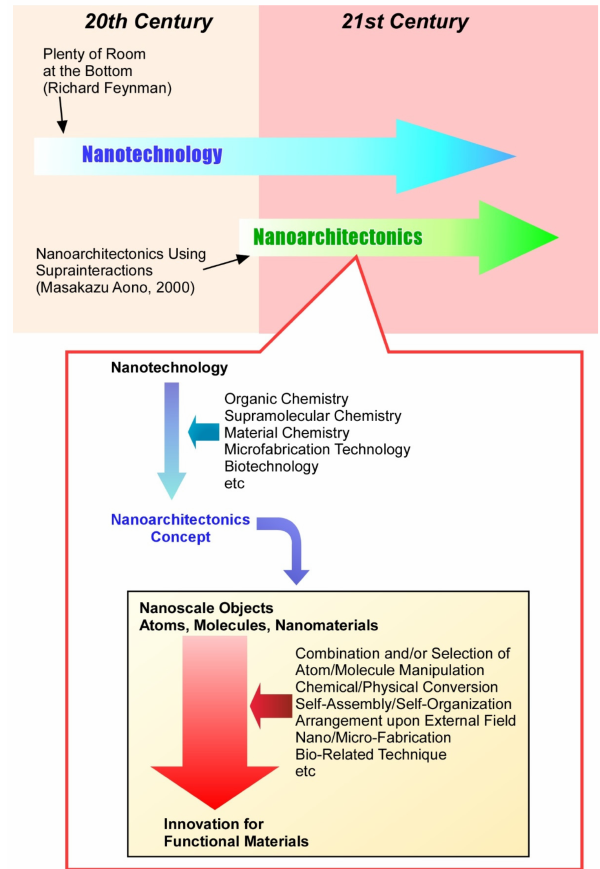
Figure 1. Outline of nanoarchitectonics concept to create functional material systems from nanoscale units such as atoms, molecules, and nanomaterials through combination and/or selection of atom/molecule manipulation, chemical/physical conversion, self-assembly/self-organization, ar- rangement on external fields, nano/micro-fabrication, and bio-related